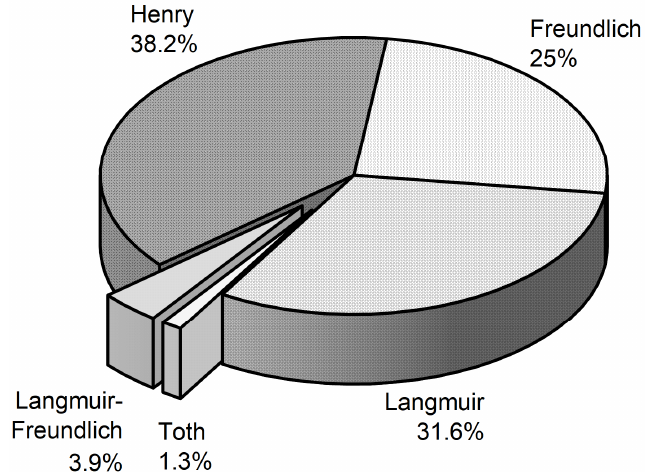
Figure 16. Percentage of the models which gave the best fit to the experimental adsorption